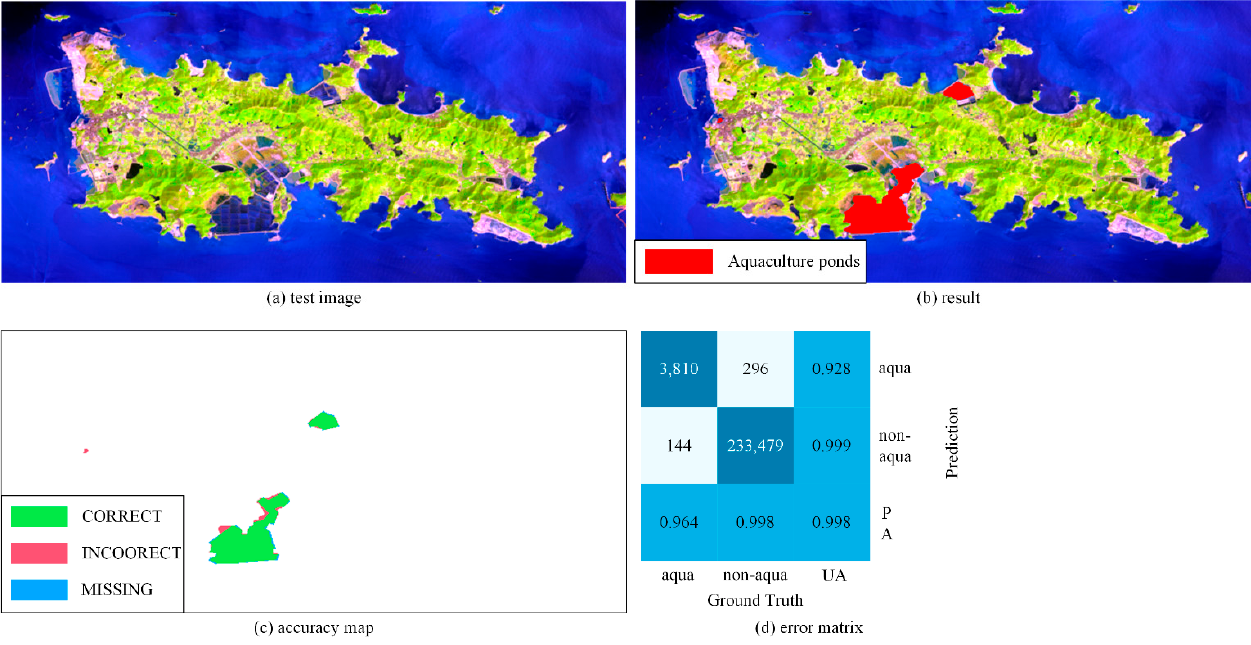
Figure 11. The extraction results of Qushan Island: ( a ) original image, ( b ) extraction result, ( c )accuracy map, ( d ) error matrix. Table 4. Accuracy evaluation of coastal aquaculture ponds extraction in Qushan Island, China.